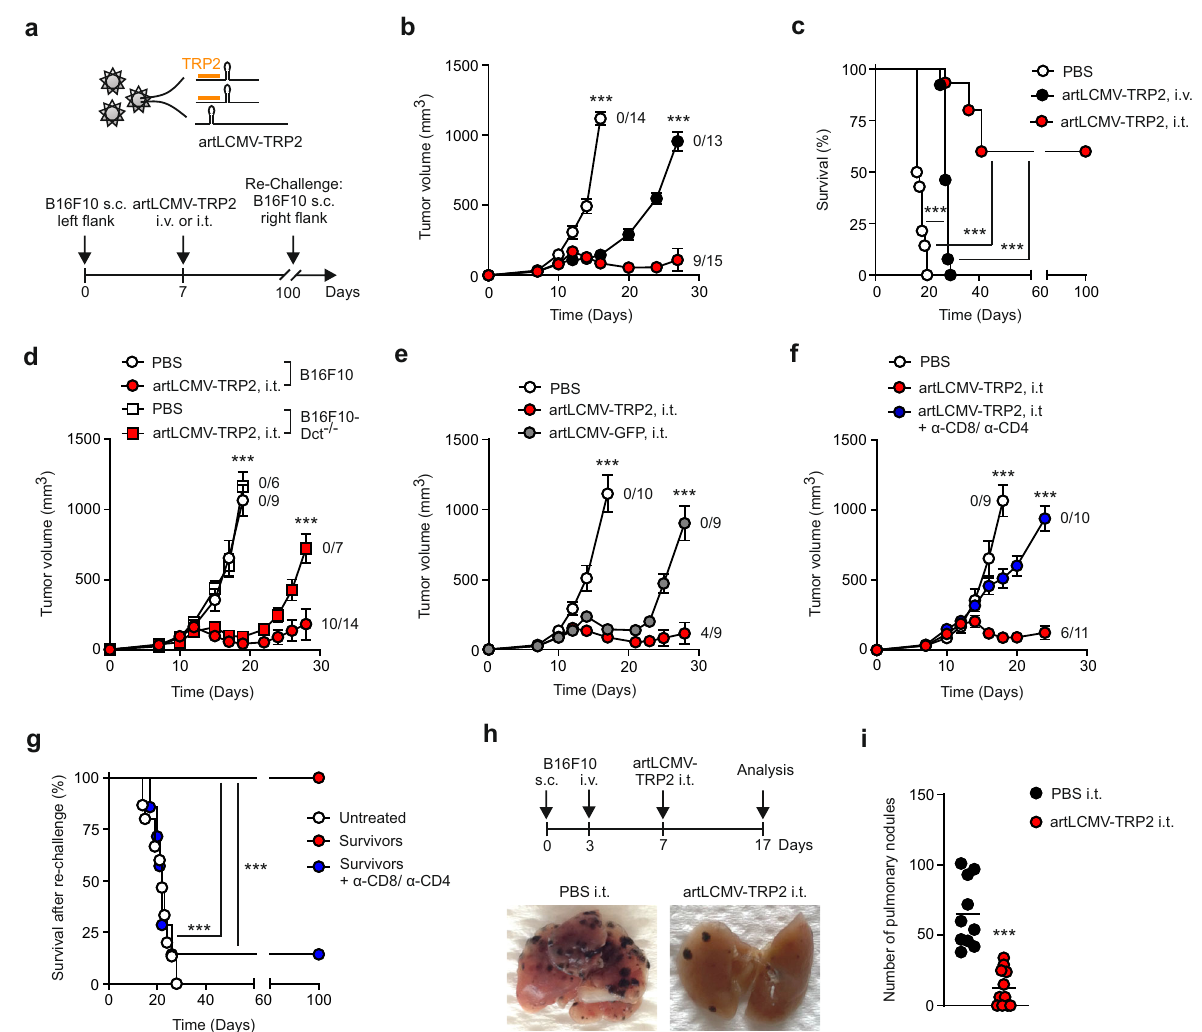
Fig. 1 Melanoma growth after intratumoral artLCMV-TRP2 treatment. a Schematic depiction of the recombinant artLCMV vector expressing the melanocyte differentiation antigen TRP2 (artLCMV-TRP2) and treatment scheme. b Tumor growth with indication of number of tumor-free mice and c survival of mice treated intratumorally (i.t.) or intravenously (i.v.) with artLCMV-TRP2. d Tumor kinetics of B16F10 and TRP2-de fi cient B16F10 (B16F10- Dct − / − ) in mice immunized i.t. with artLCMV-TRP2. e Tumor growth with indication of number of tumor-free mice of mice treated i.t. with artLCMV-TRP2 or -GFP. f Tumor growth in mice administered with anti-CD8- and anti-CD4-depleting antibodies and treated i.t. with artLCMV-TRP2. g Surviving mice from c were re-challenged with B16F10 s.c. into the opposite right fl ank. In one cohort of mice, CD8- and CD4-depleting antibodies were administered. h , i Mice were inoculated with s.c. B16F10 on day 0 and i.v. on day 3 to establish pulmonary melanoma metastasis. On day 7, mice were treated i.t. with artLCMV-TRP2 and on day 17 lungs were harvested. Analysis of lungs for pulmonary tumor metastasis with representative images ( h ) and quanti fi cation ( i ). Dots indicate mean±s.e.m. values for each time point. Pooled data from three independent experiments with n = 14 (PBS), n = 13 (artLCMV-TRP2, i.v.) and n = 15 (artLCMV-TRP2, i.t.) mice ( b , c ), n = 15 (Untreated), n = 13 (Survivors) and n = 7 (Survivors + α -CD8/ α -CD4) mice ( g ); n = 10 (PBS, i.t.) and n = 11 (artLCMV-TRP2, i.t.) mice ( i ). Pooled data from two independent experiments with n = 9 (B16F10, PBS), n = 6 (B16F10-Dct − / − , PBS), n = 14 (B16F10, artLCMV-TRP2, i.t.) and n = 7 (B16F10-Dct − / − , artLCMV-TRP2, i.t.) mice ( d ); n = 10 (PBS), n = 9 (artLCMV-GFP, i.t.) and n = 9 (artLCMV-TRP2, i.t.) mice ( e ); n = 9 (PBS), n = 11 (artLCMV-TRP2, i.t.) and n = 10 (artLCMV-TRP2, i.t. + α -CD8/ α -CD4) mice ( f ). Statistical analysis was performed using two-way analysis of variance (ANOVA) with Bonferroni ( b , d , e , f ), Log-Rank Mantel – Cox test ( c , g ), or unpaired two-tailed Student ’ s t test ( i ) with * P <0.05: ** P <0.01; *** P <0.001. Source data and exact P values are provided in the Source data fi le.